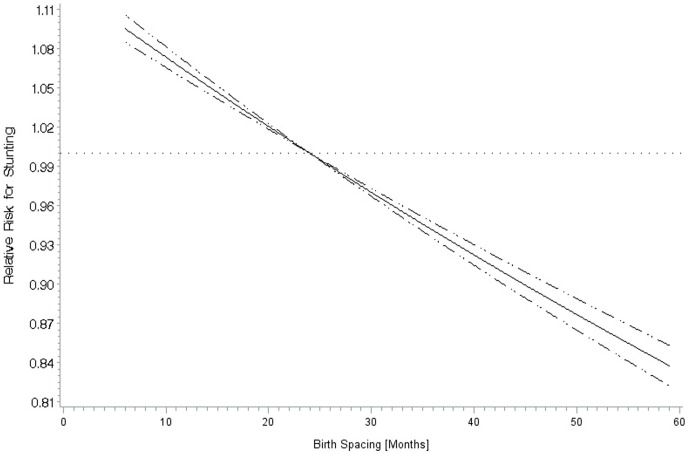
Linear adjusteda relationship of birth spacing with stuntingb among children of birth order 2-5.
a Adjusted for same factors as Table 1 Caption. b 24 months is the reference group (p-value for linear relationship: <0.001).